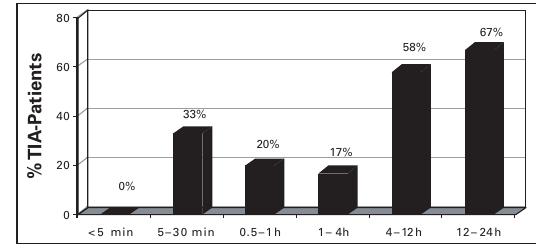
Figure 1 Symptom duration correlates with the likelihood of visual - ised DWI lesion in TIA patients (adapted from [16]).